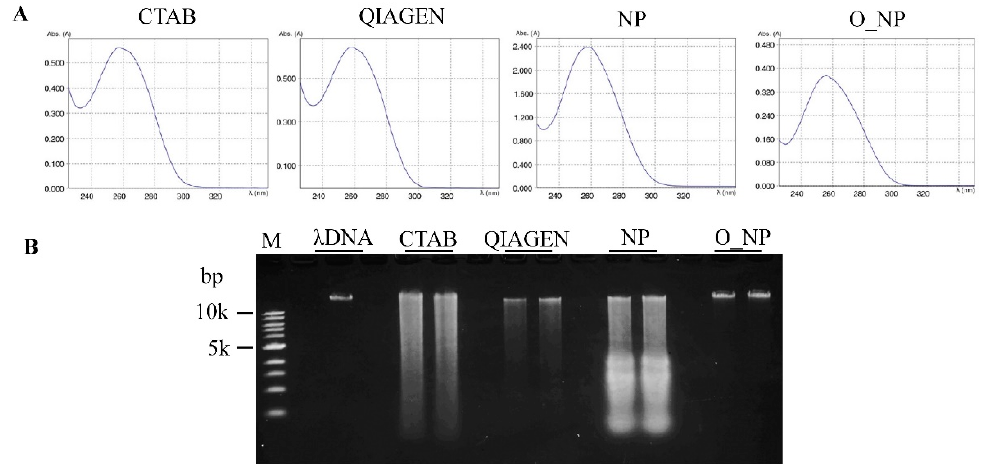
Figure 2. Genomic DNA quality assessment. Genomic DNA from young leaves of rice ( Oryza sativa L.) plant was extracted by the traditional hexadecyltrimethylammonium bromide (CTAB)-based (CTAB), QIAGEN DNeasy Plant Mini Kit (QIAGEN), NP, and optimized NP (O_NP) methods. ( A ) Comparison of the absorbance profile of genomic DNA at different wavelengths by Eppendorf BioSpectrometer ® fluorescence. ( B ) Comparison of genomic DNA integrity using agarose gel electrophoresis. DNA was resolved by electrophoresis in a 0.8% agarose gel and visualized using an ethidium bromide stain. M represents 1 kb DNA ladder (Toyobo Co., Ltd, Osaka, Japan).